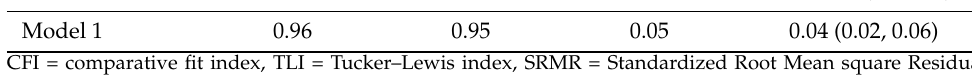
Table 6. Model fit indices of the initial structural model. Model CFI TLI SRMR RMSEA (90% CI) Model 1 0.96 0.95 0.05